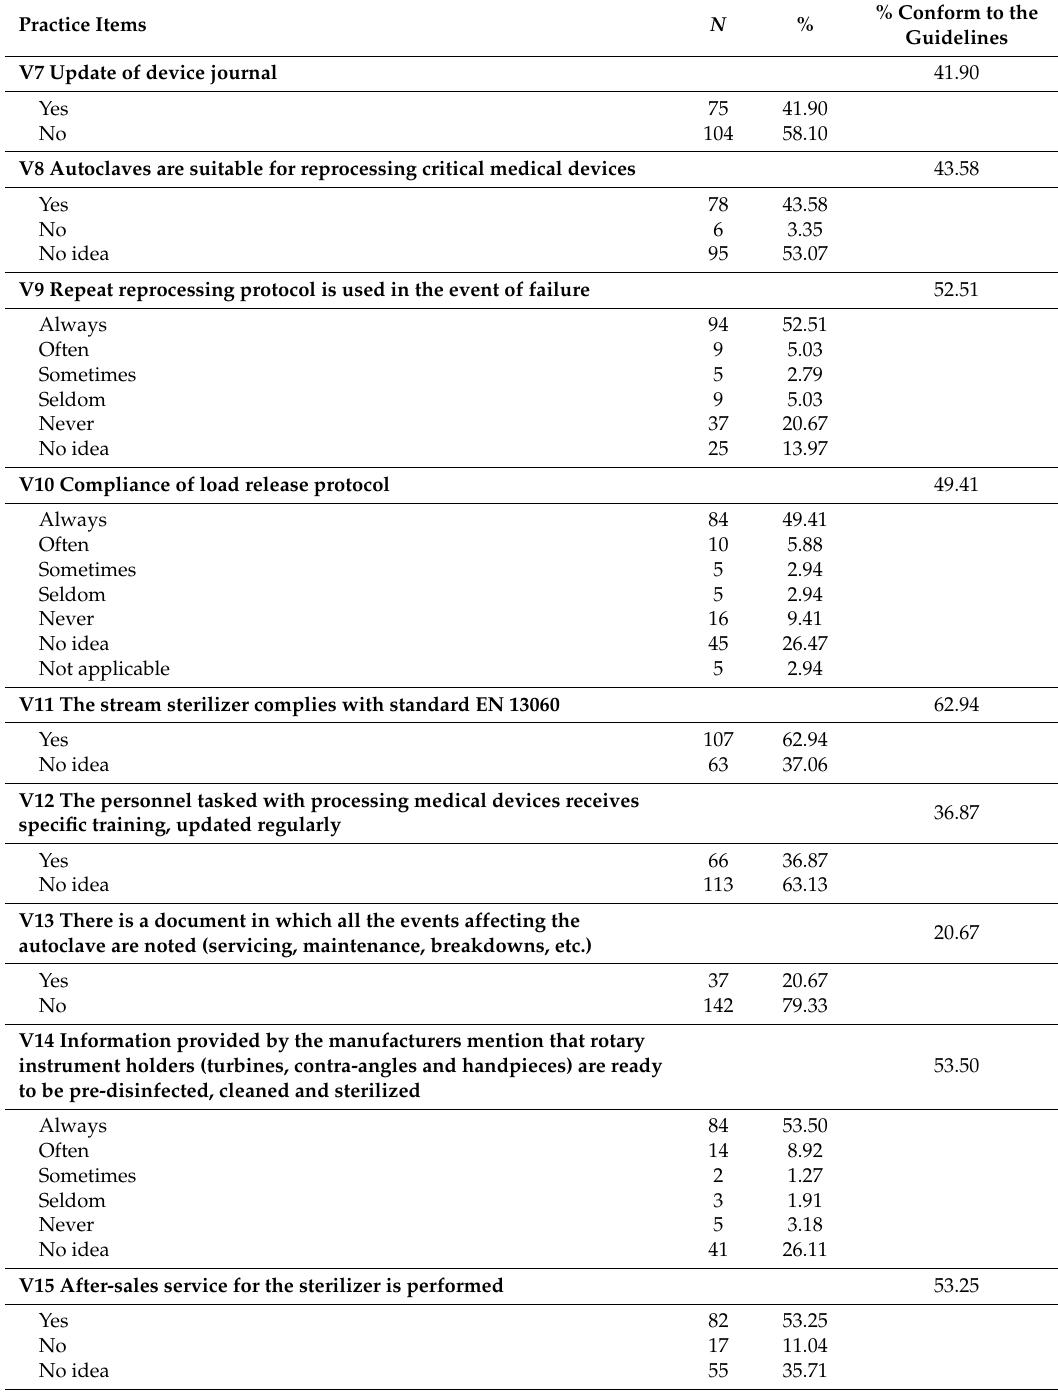
Table 2. Descriptive analysis: Biological verification of sterilization cycles—Monitoring steam sterilization procedure (Group 2) ( N =